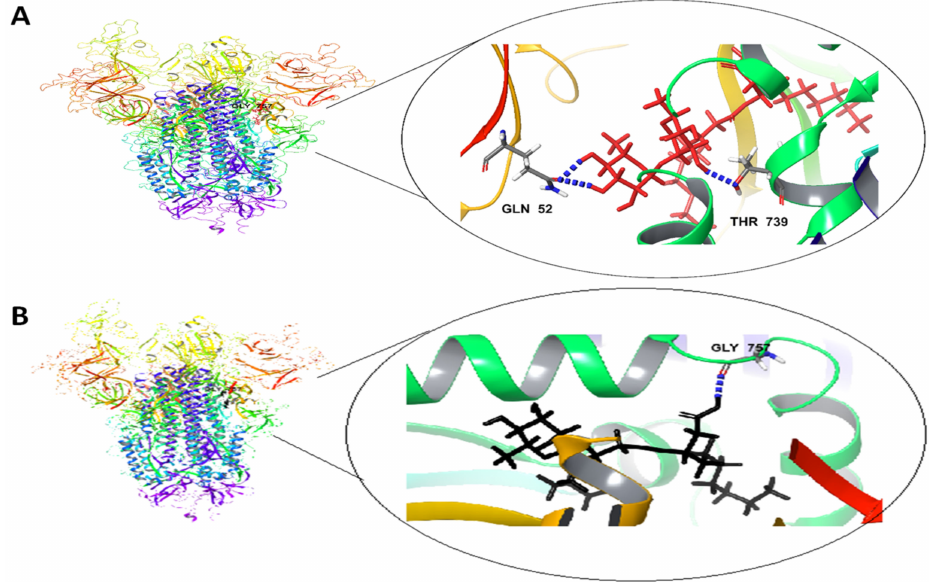
Figure 3. In silico docking study revealing the interactions between ( A ) Rha(s)1 and ( B ) Rha(s)2 with spike glycoproteins (S1- N -terminal domain (NTD) and S2 part) of SARS-CoV-2. PDB accession number for spike glycoproteins is